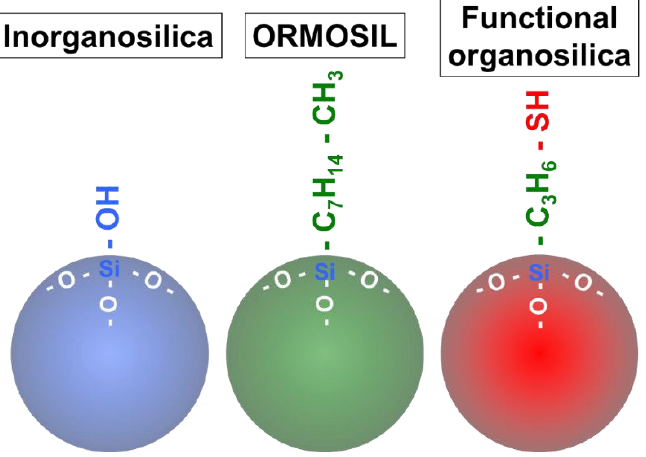
Figure 1. Schematic structure of three types of silica nanoparticles.